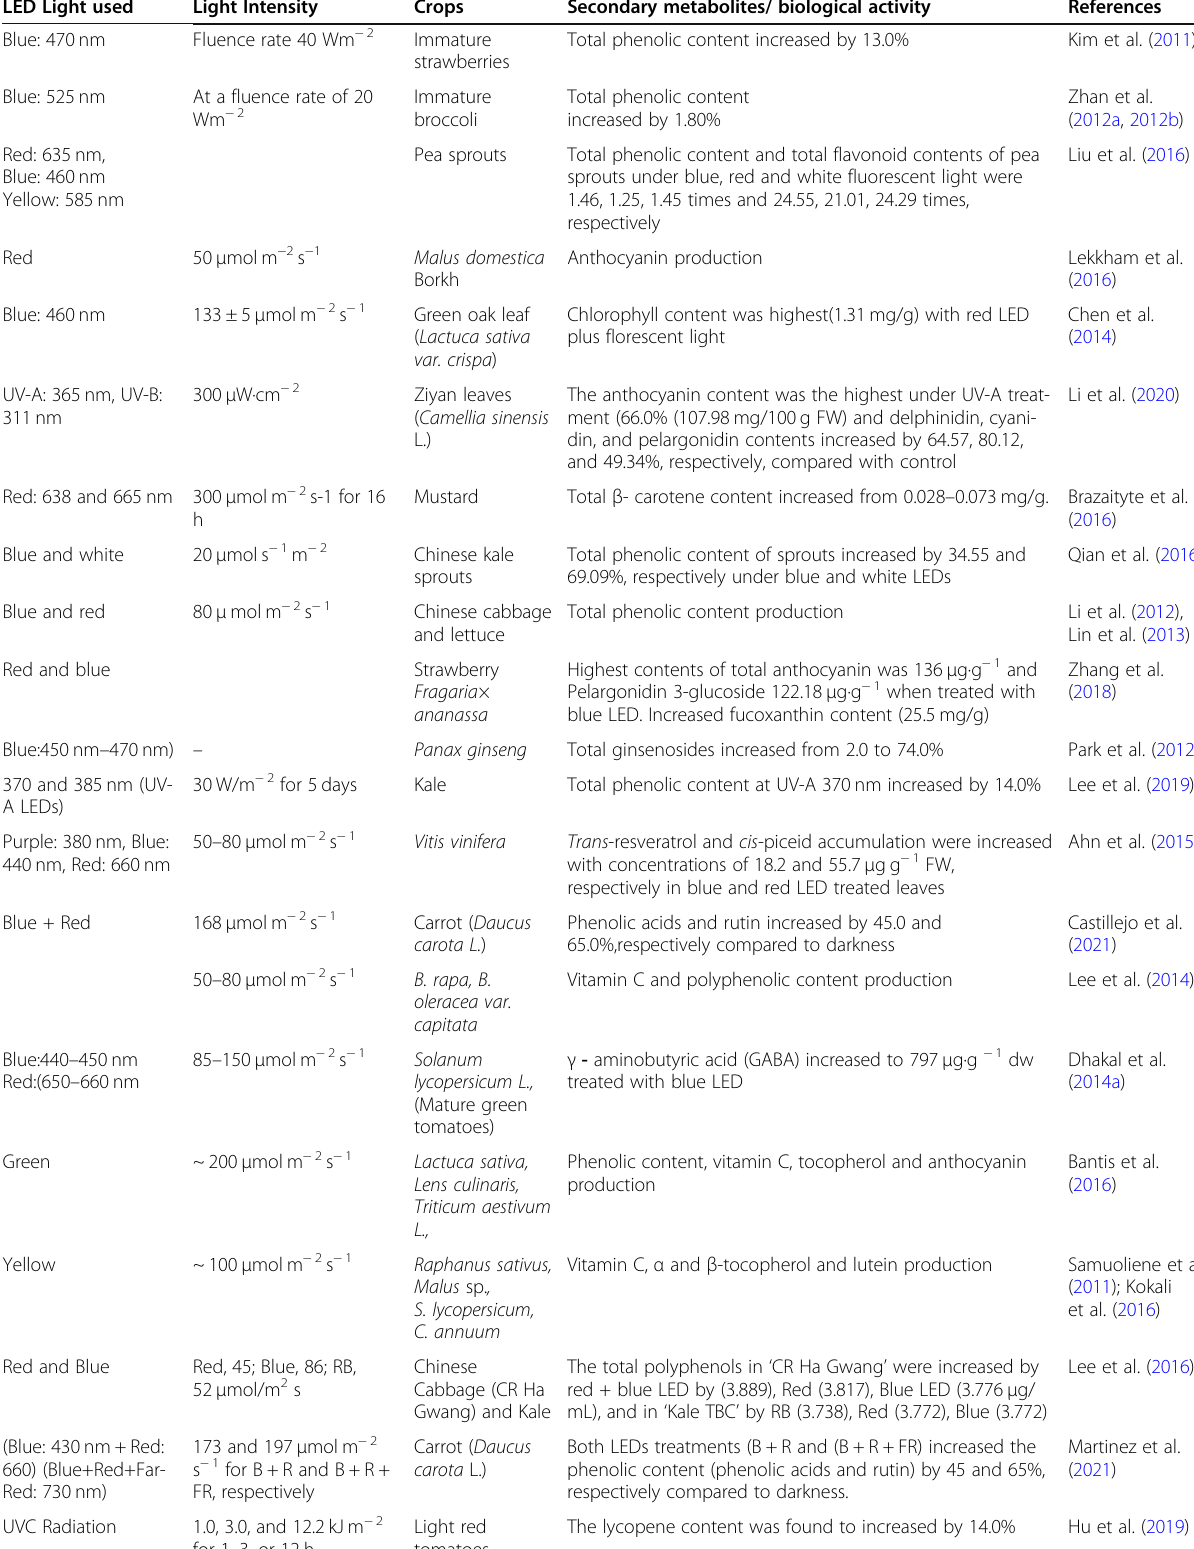
Table 3 LED employed for enhancement of secondary metabolites and biological activity in fruits and vegetables LED Light